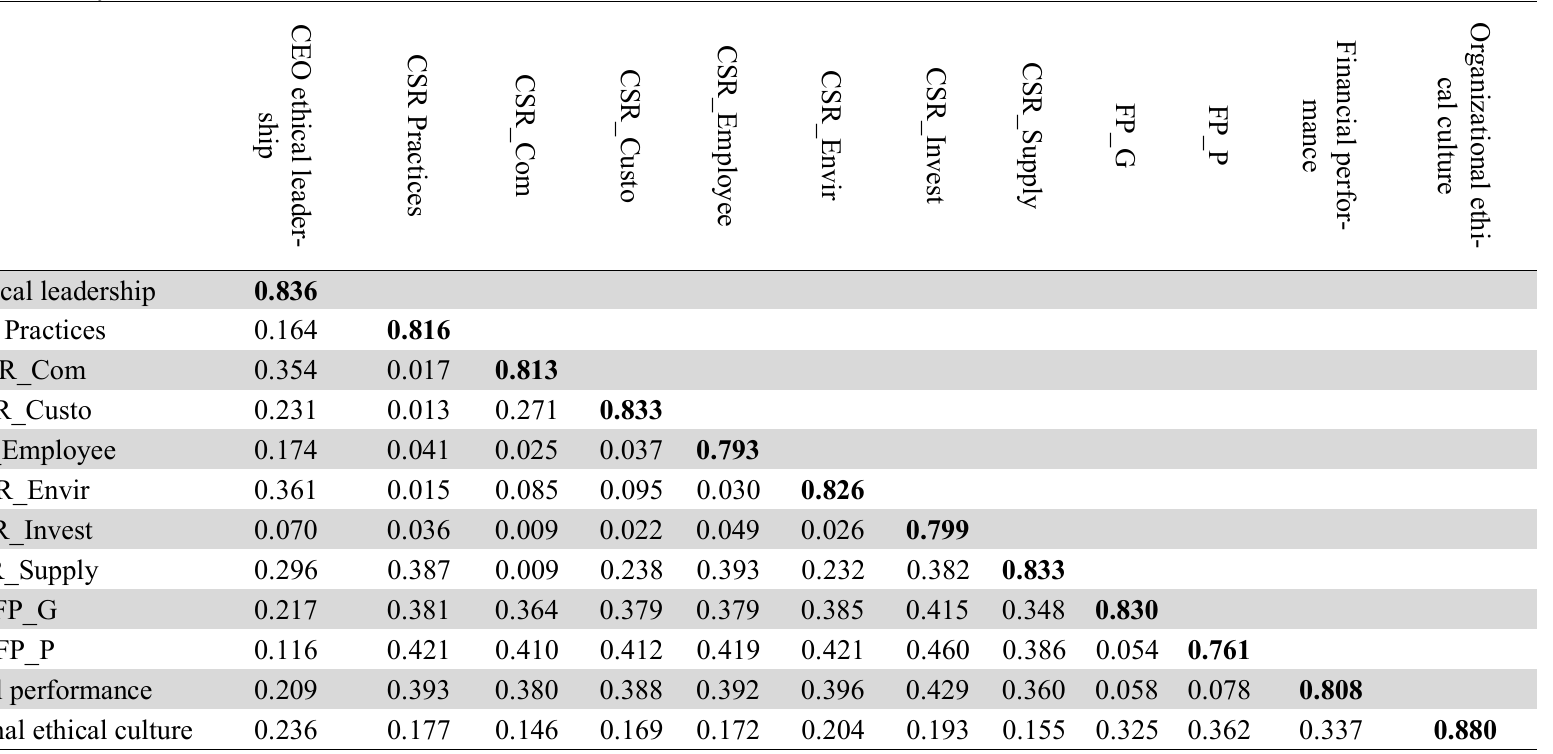
Discriminant Validity Fornell-Larcker